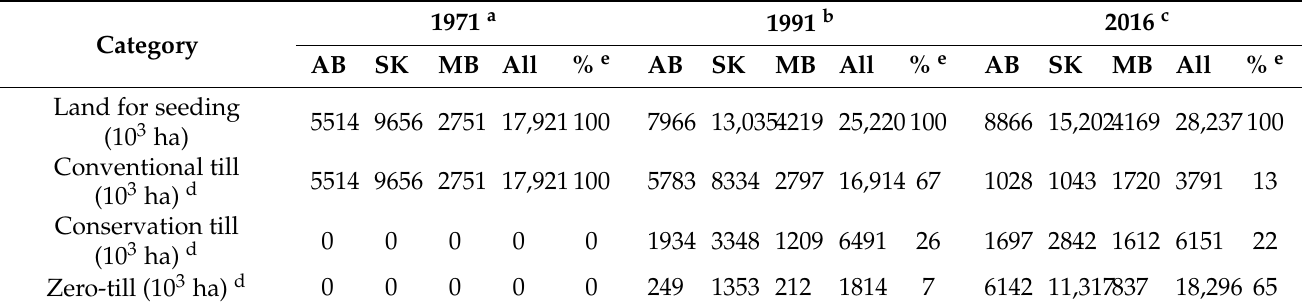
Table 6. Summary of tillage operations in the Canadian Prairies in 1971, 1991, and 2016, showing the increasing trend of conservation tillage and